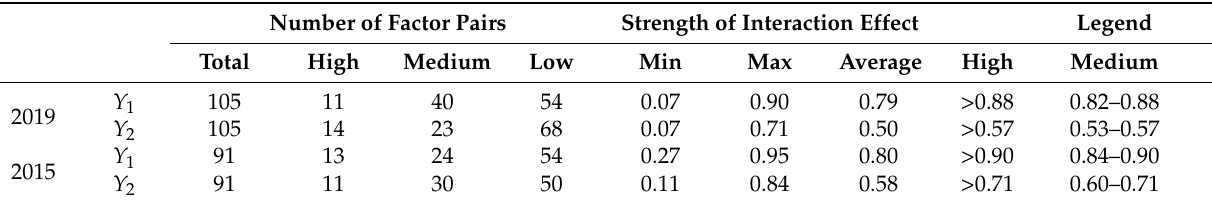
Table 4. Statistical analysis of factor pairs and interaction forces.